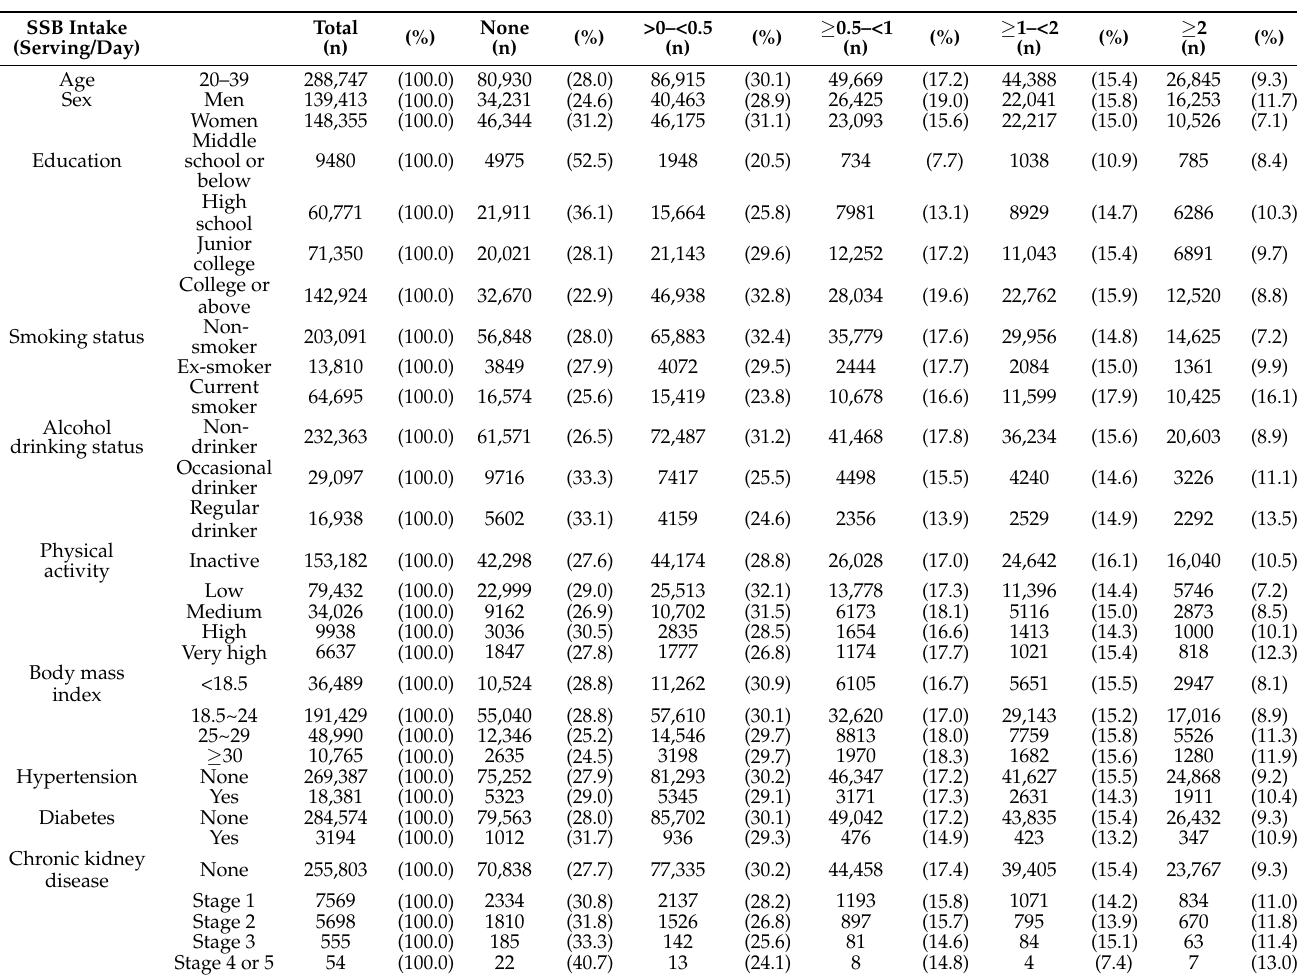
Table 1. The characteristics of the younger participants in this study.